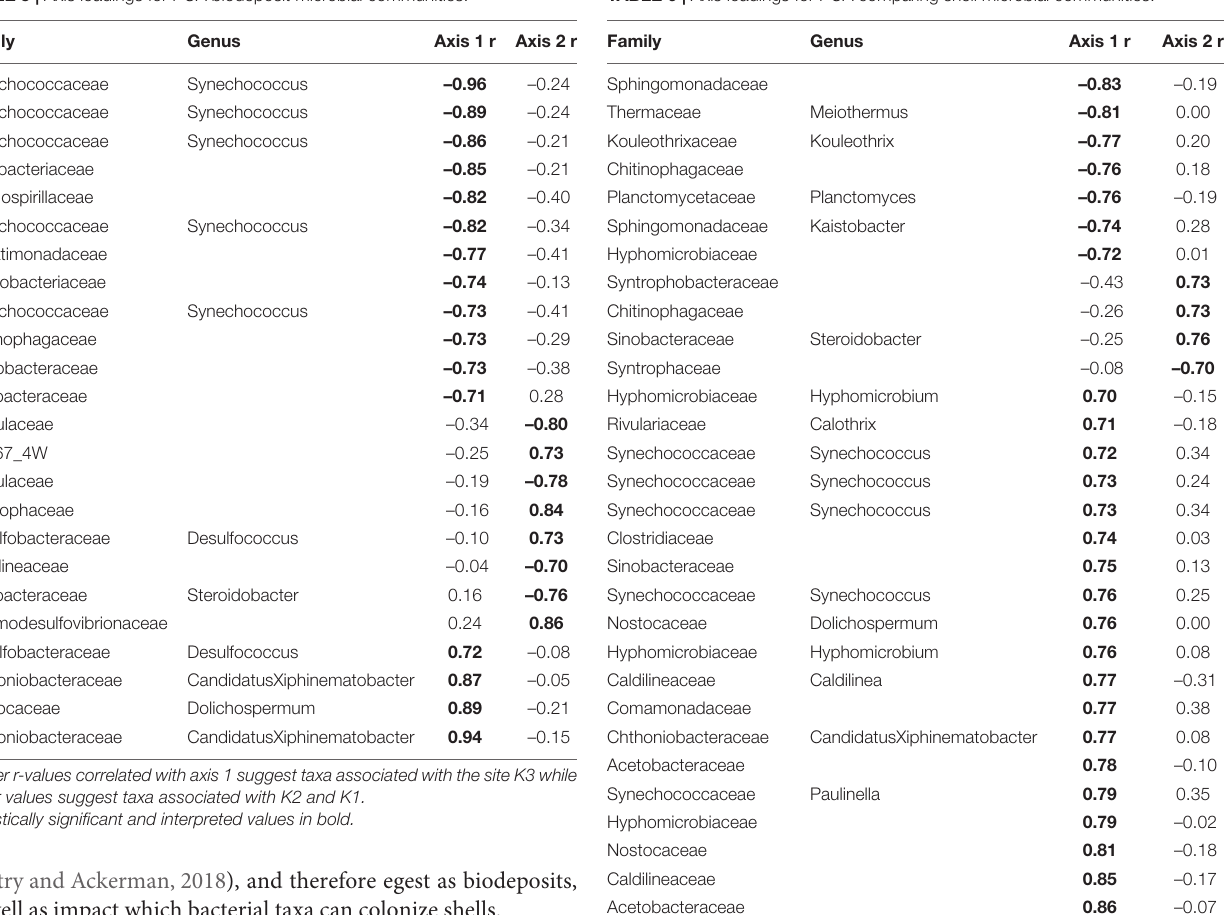
TABLE 5 | Axis loadings for PCA biodeposit microbial communities. TABLE 6 | Axis loadings for PCA comparing shell microbial